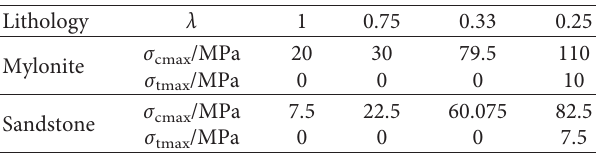
Figure 12: The fault zones and notch formation: (a) the displacement field, (b) the damaged notches near the opening, and (c) the sandstone fault pattern [11]. Table 2: Statistics of the maximum compressive stress and the maximum tensile stress with different λ